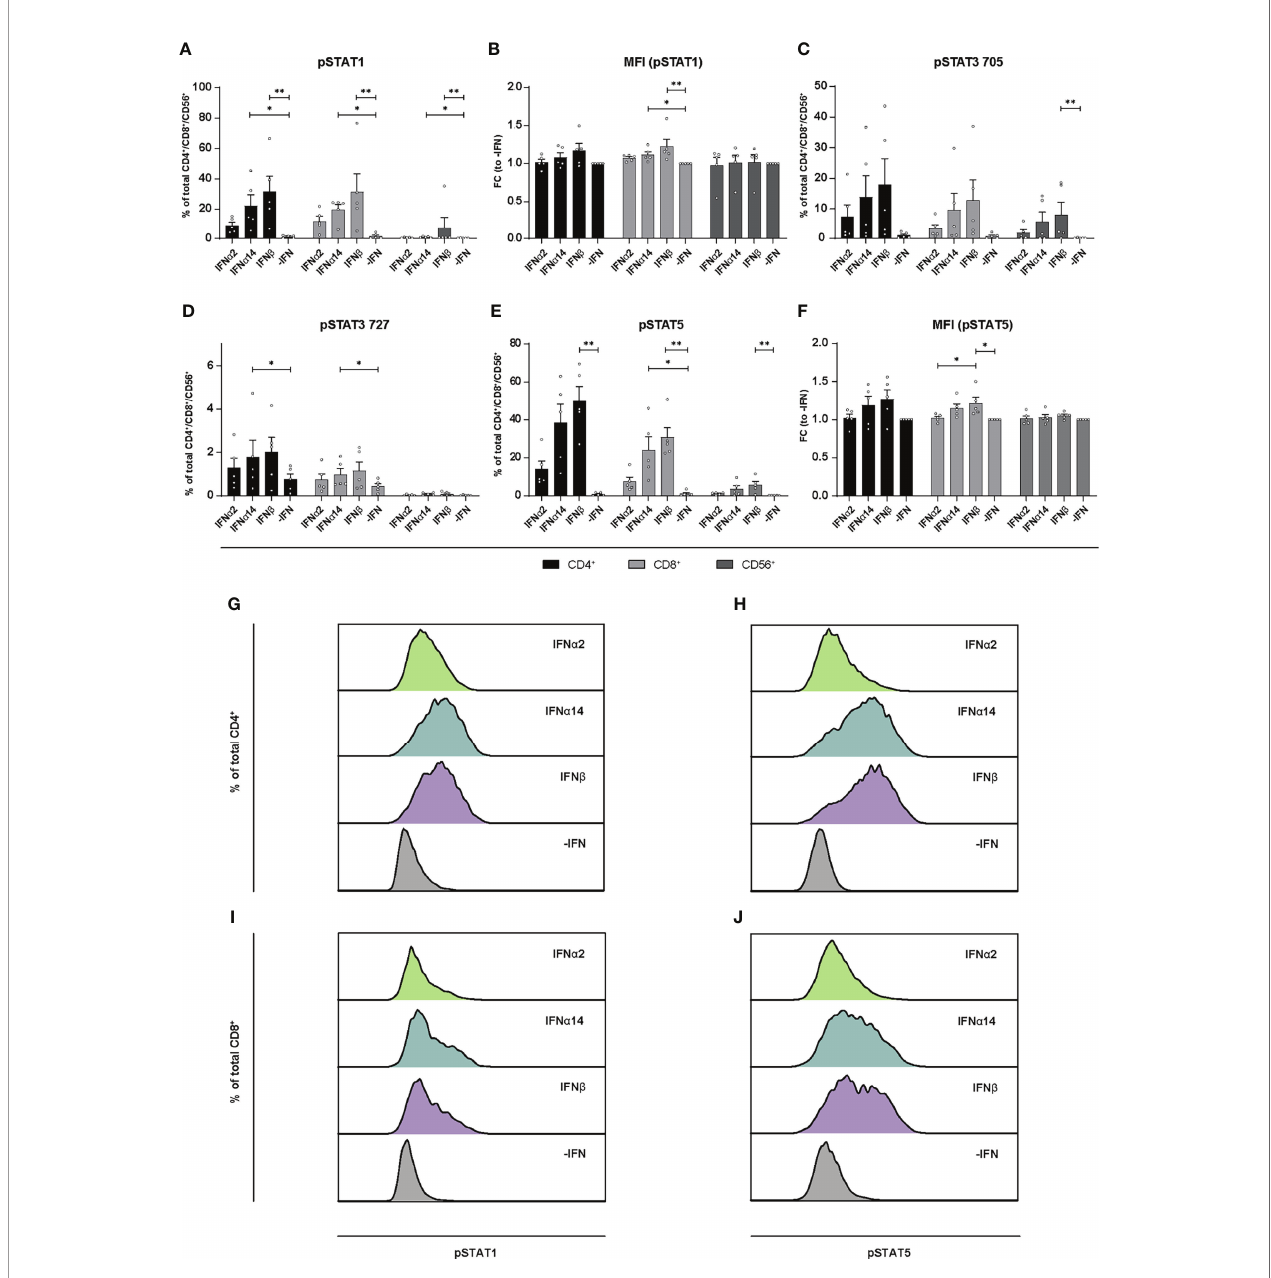
FIGURE 8 | Phosphorylation of STAT molecules after IFN stimulation in PBMCs from PLWH. PBMCs from PLWH were stimulated with 2000 U/ml IFN a 2, IFN a 14, IFN b , or without IFN (-IFN) in presence of the surface markers anti-CD3, anti-CD4, anti-CD8, anti-CD56, and the viability marker FVD. Cells were then fi xated and permeabilized for phosphostaining with anti-STAT1 pTyr702, anti-STAT5 pTyr694, anti-STAT3 pTyr705, and anti-STAT3 pSer727. (A) Frequencies of phosphorylated STAT1, (B) mean donor-speci fi c fold changes of MFI (pSTAT1) (C) frequencies of phosphorylated STAT3 pTyr705, (D) STAT3 pSer727, (E) STAT5, and (F) mean donor- speci fi c fold changes of MFI (pSTAT5) on CD4 + , CD8 + T, and NK cells. Mean values ± SEM are shown for n=5. Statistical analyses between the treated groups within a cell population were done by using Friedman test and Dunn ’ s multiple comparison test. **, P < 0.01; *, P < 0.05. (G, H) Representative histograms of phosphorylated STAT1 and STAT5 expression by unstimulated or IFN-stimulated by CD4 + T cells, and (I, J) CD8 + T